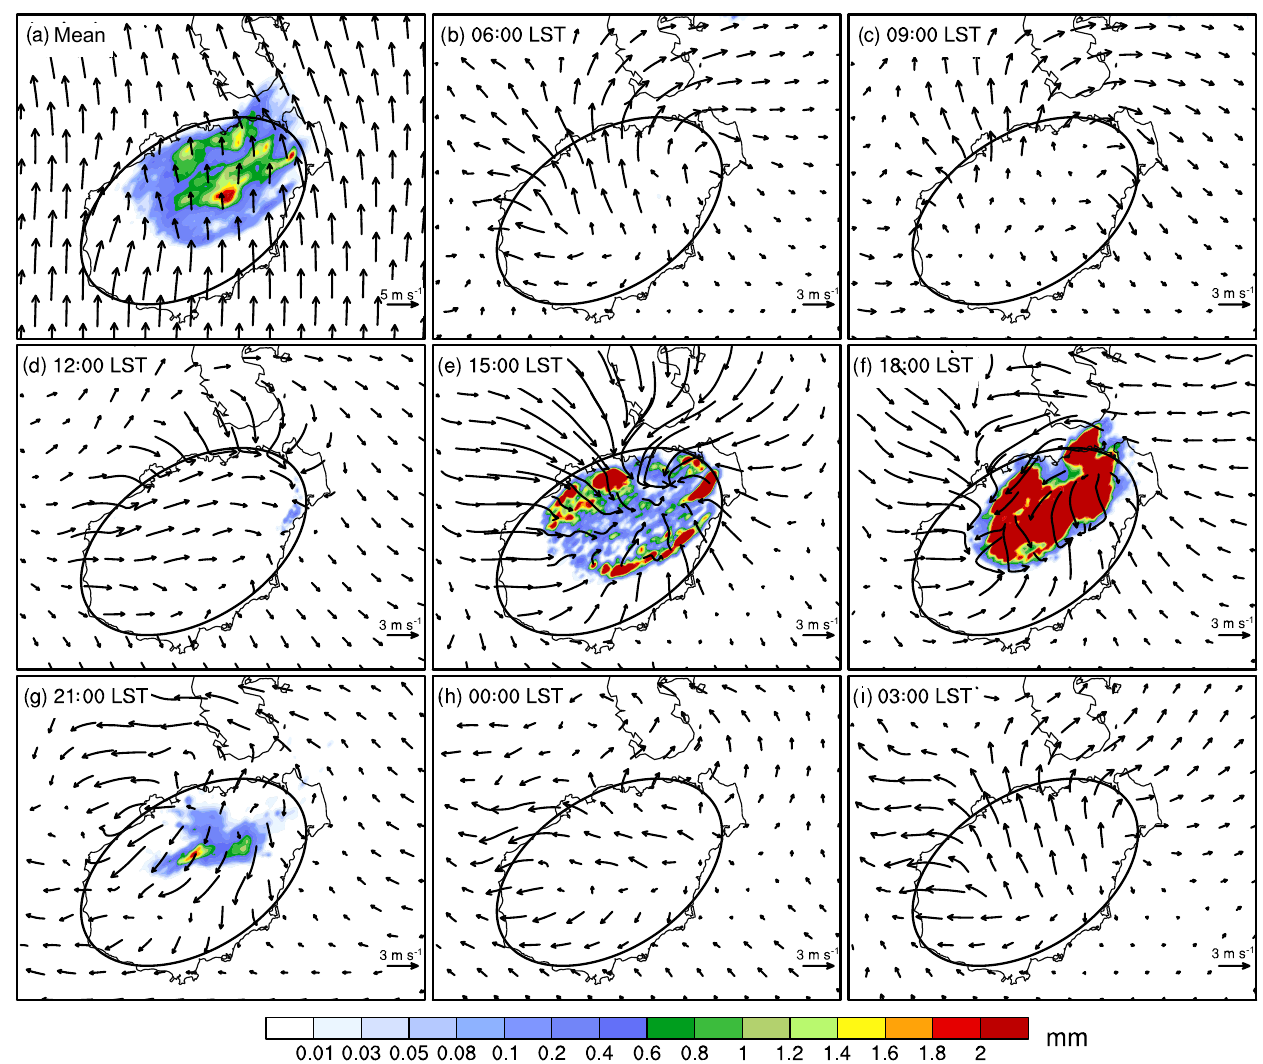
Figure 10. As in Fig. 8 but for the IDEAL experiment.